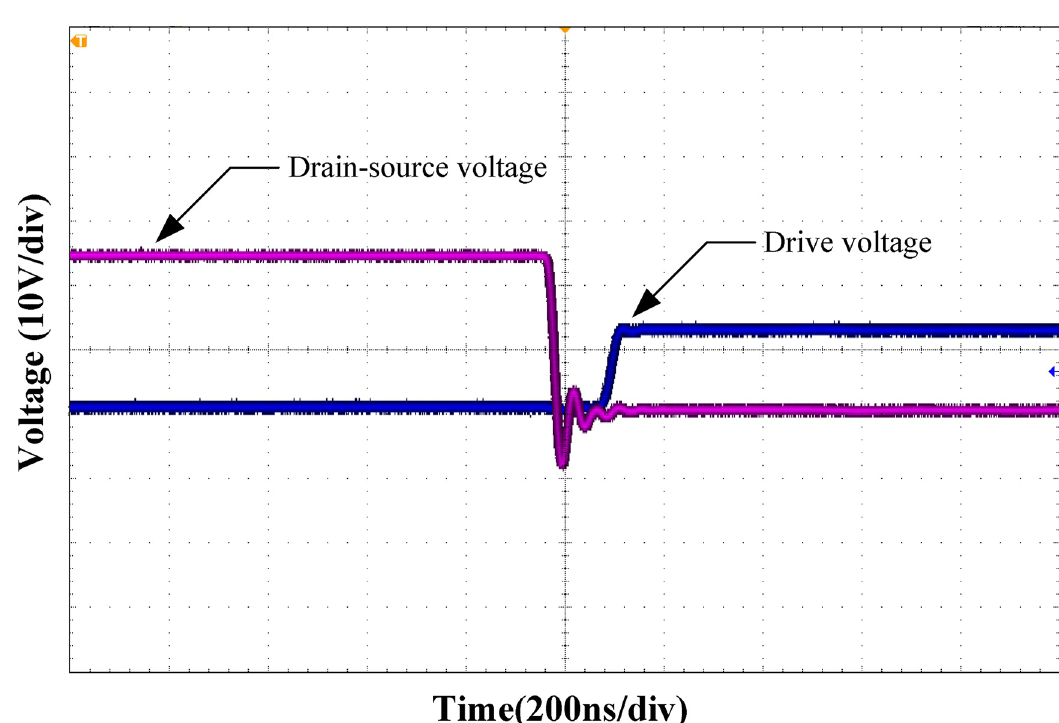
Fig 19. Zero-voltage turn-on waveform of the leading-leg.